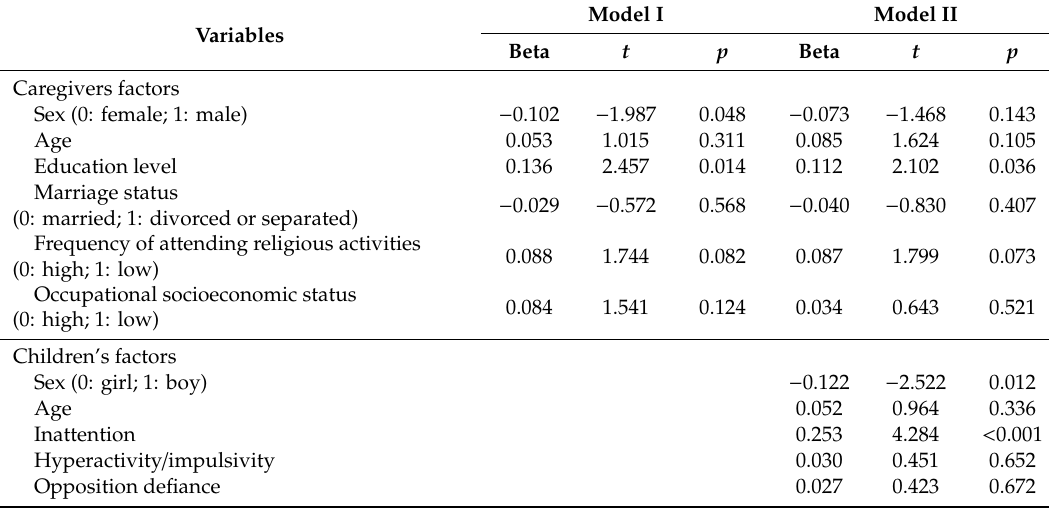
Table 2. Caregivers’ and children’s factors related to total a ffi liate